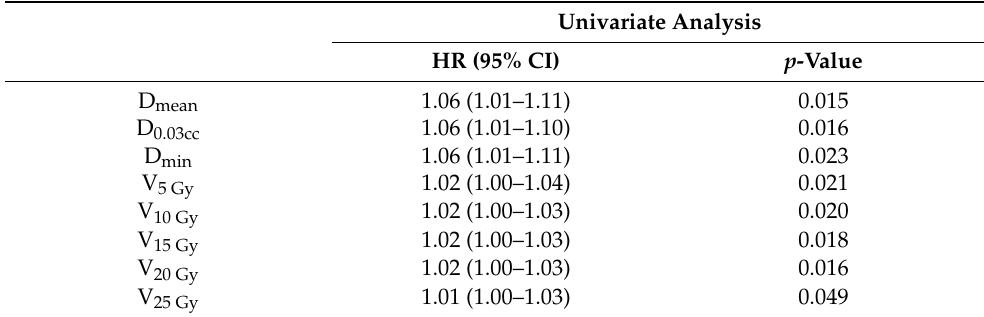
Table 3. Univariate competing risk analysis of dosimetric parameters of pancreas for predicting the development of diabetes mellitus.